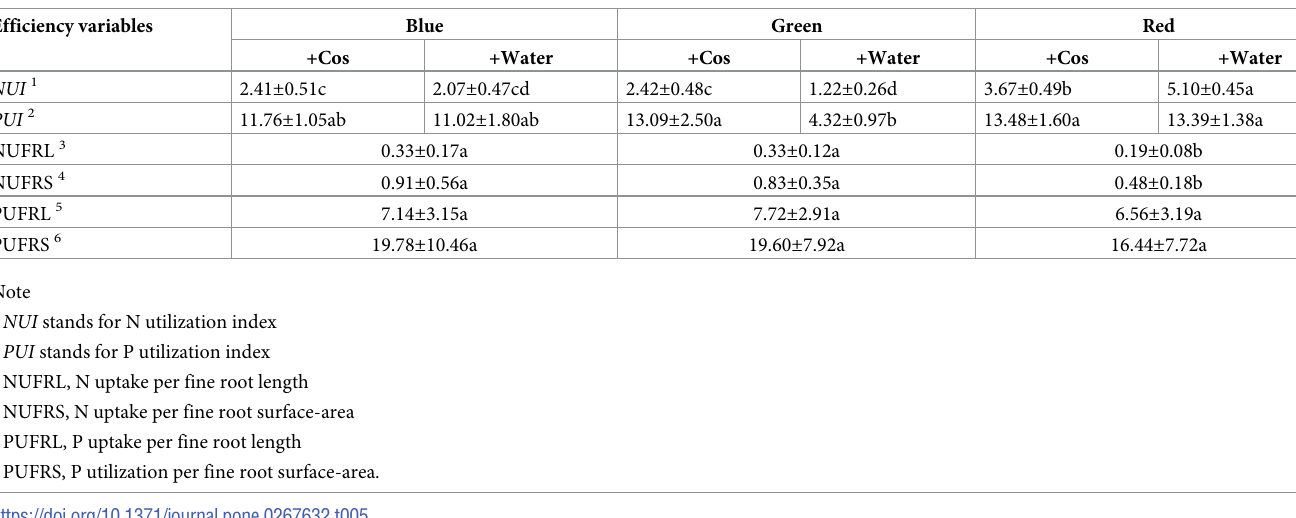
spectra from red, green, and blue lights. Bar height corresponds to the mean of the measurement while the error bars represent standard errors. Different letters represent difference at significant level of 0.05 by Tukey test.